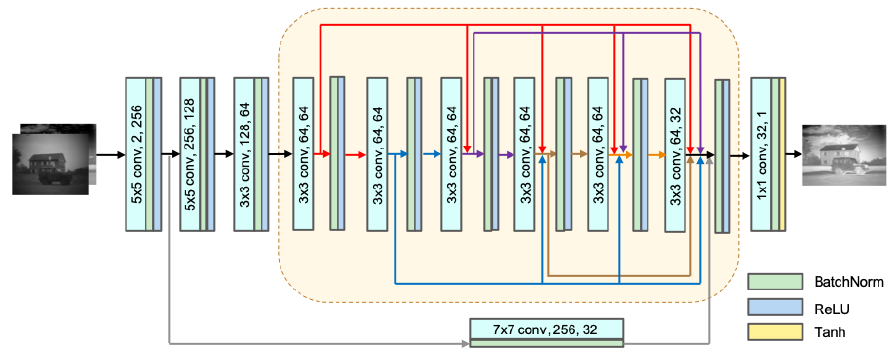
Figure 2. Generator network